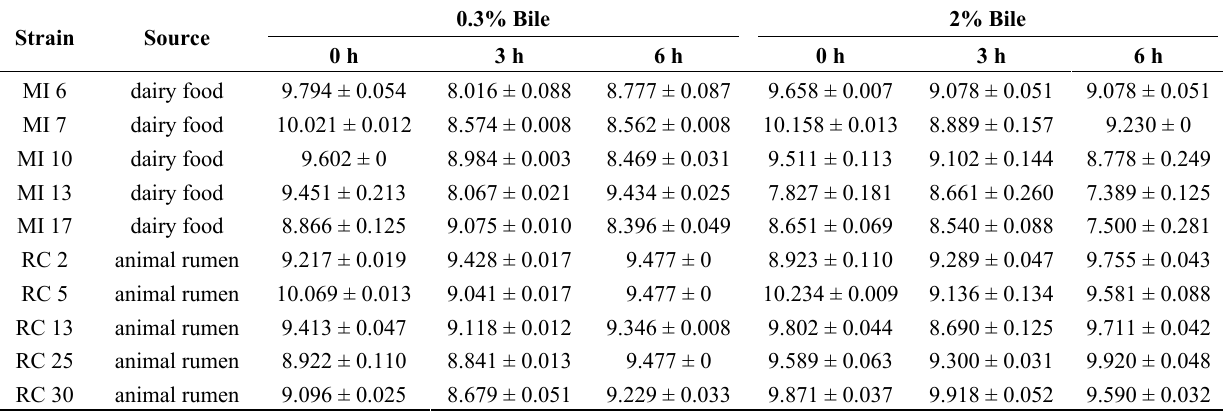
Table 3. Strain viability after 0, 3 and 6 h incubation in 0.3% or 2% bile